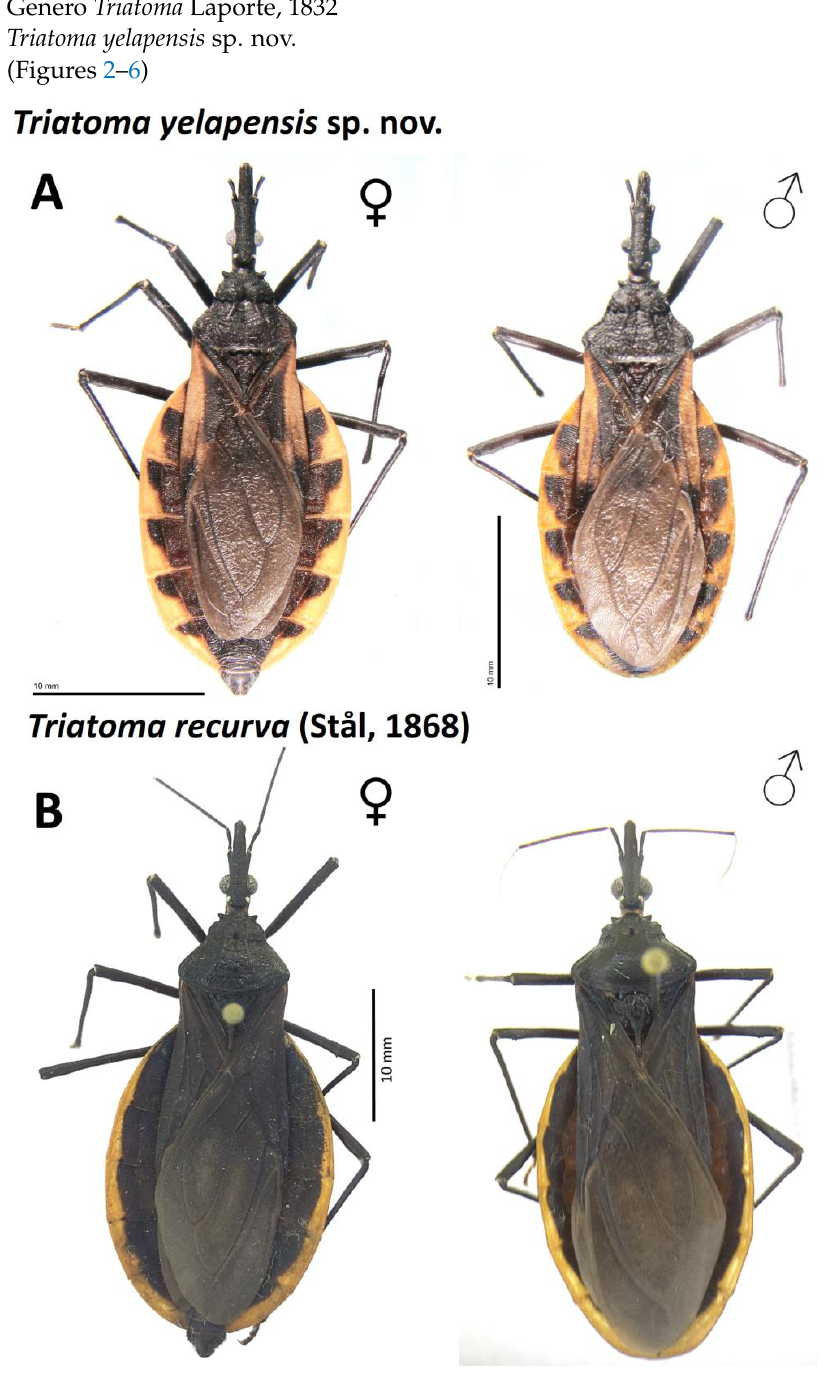
Figure 3. ( A ) Triatoma yelapensis sp. nov., female (paratype) and male (holotype) in dorsal view. ( B ) Triatoma recurva , female and male in dorsal view.